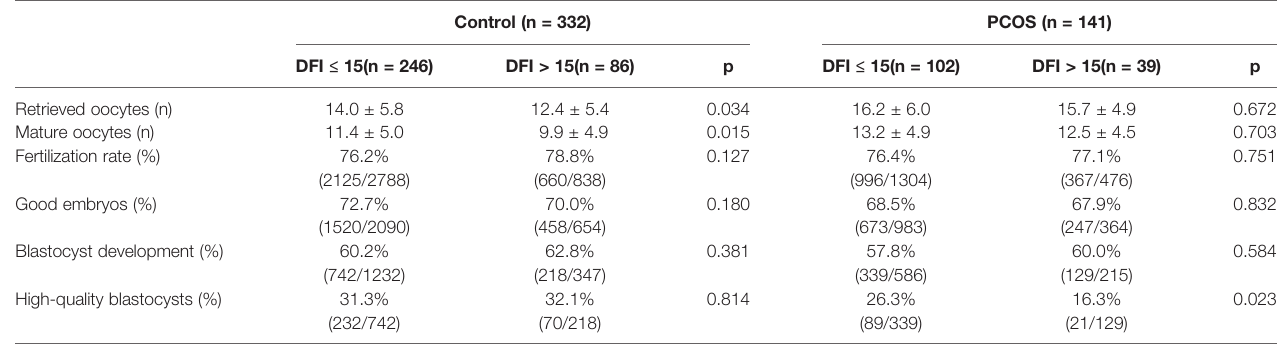
TABLE 2 | IVF-ET laboratory characteristics in control and PCOS patients with different sperm DFI.